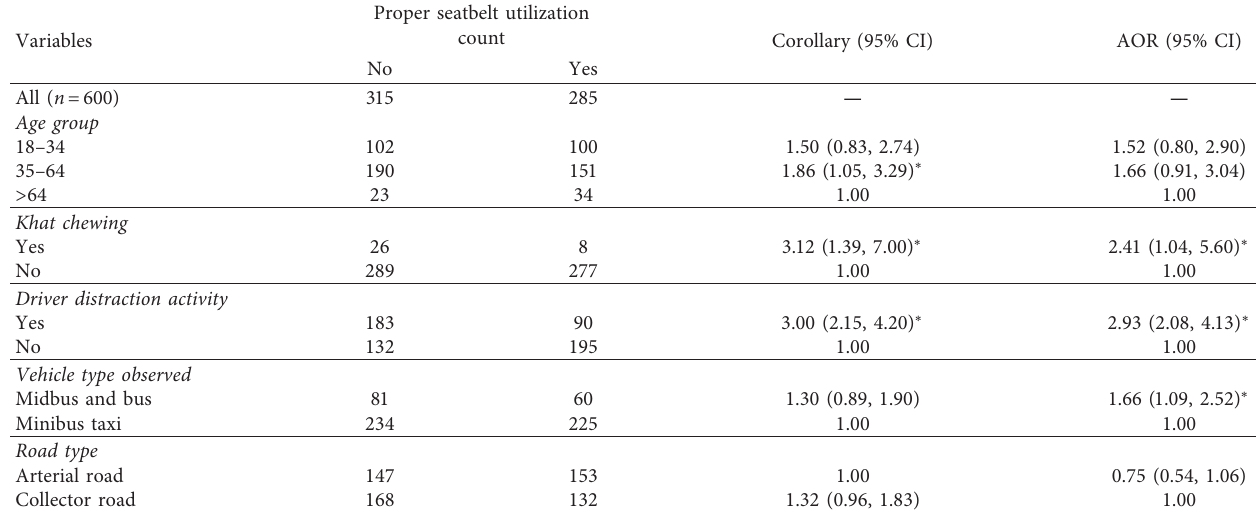
Table 3: Association between nonuse of proper seatbelt and observable factors among public transport vehicle drivers in Addis Ababa, Ethiopia, February 2017